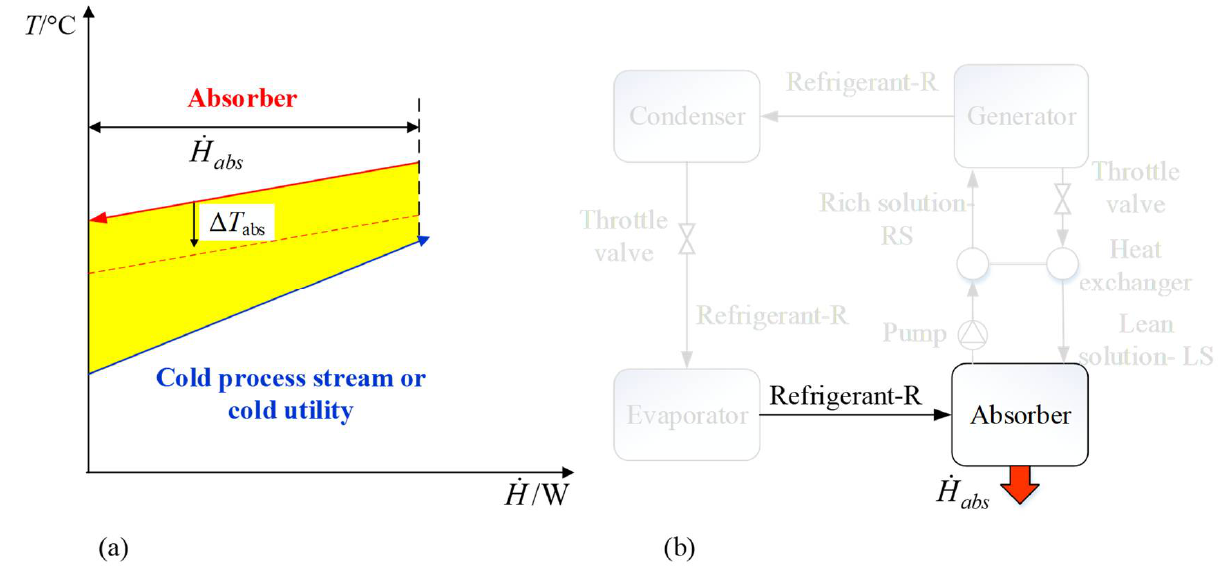
Figure 3. ( a ) Heat integration of the absorption process presented by a composite curve and ( b ) presentation of absorber as a part of AC cycle.